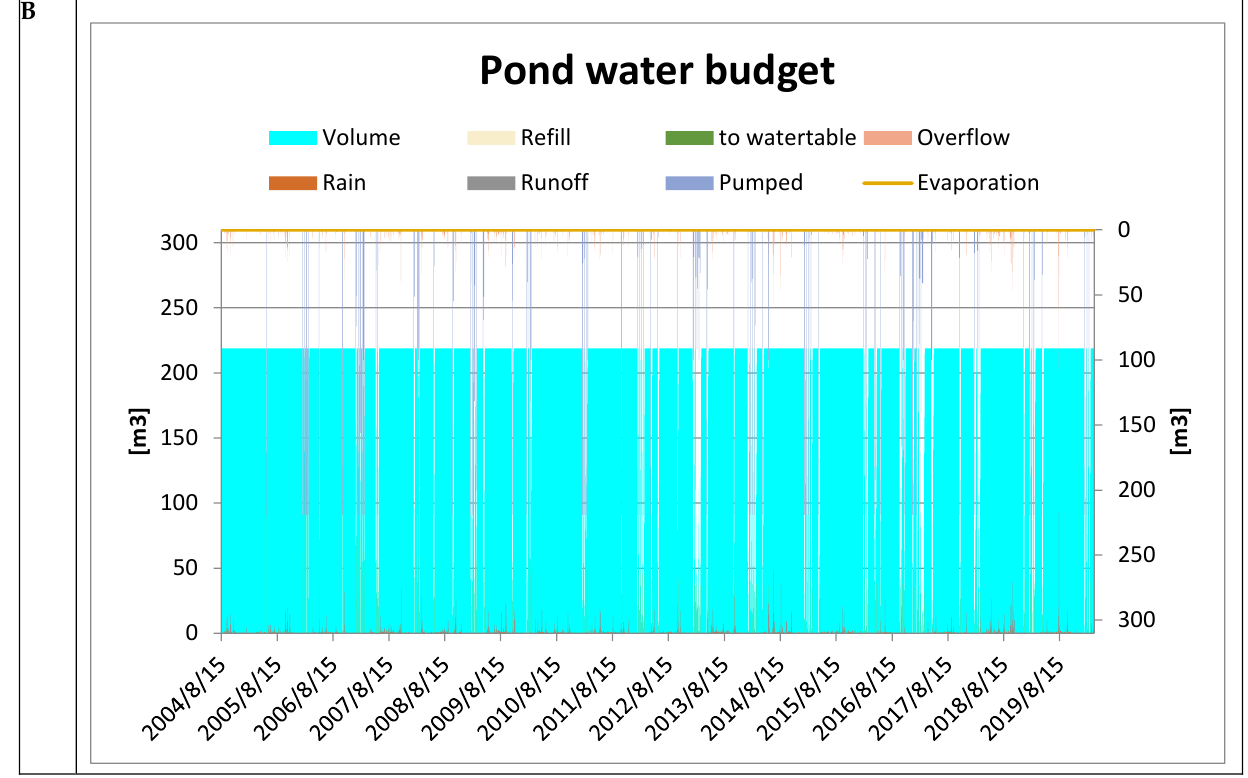
Figure 5. Pond water budget for Sc1 ( A ) and Sc3 ( B ).